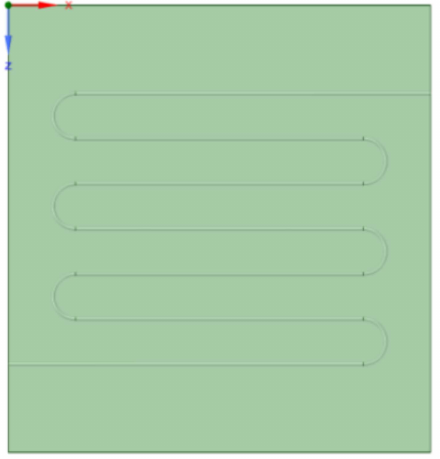
Figure 2. 3D model of the one-inlet-one-outlet serpentine flow